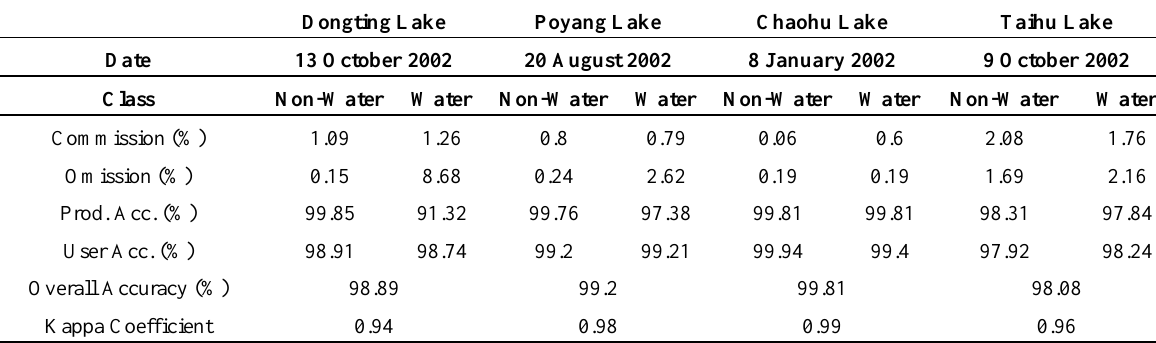
Table 3. Summary of classification accuracy of the four lakes.